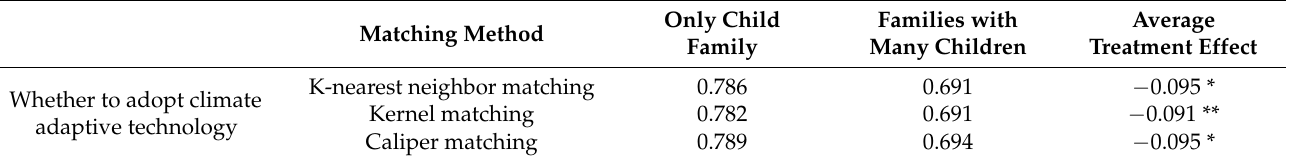
Table 4. Re-estimation of climate adaptive technology selection under different number of children. Matching Method